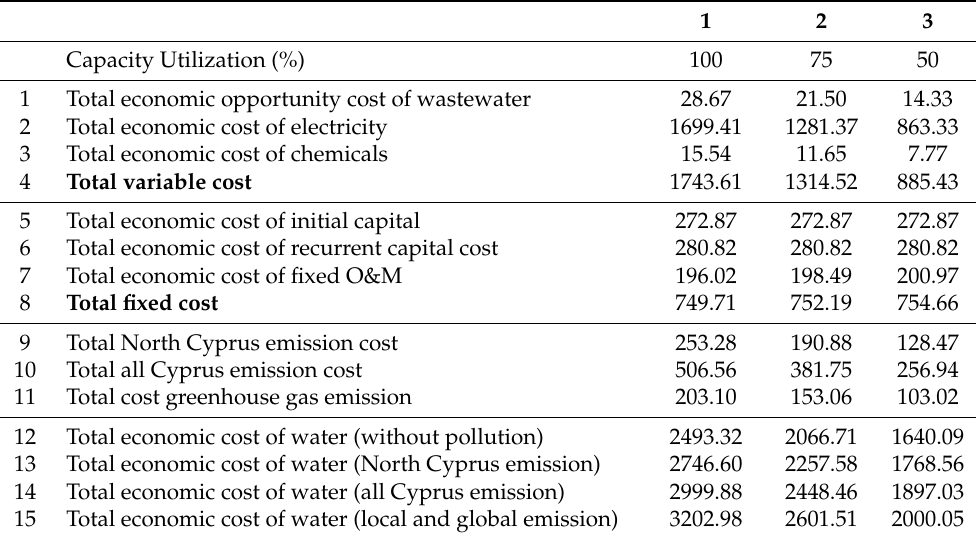
Table 6. Present value @ 8% Total Economic Costs for Different Levels of Capacity Utilization, ’000